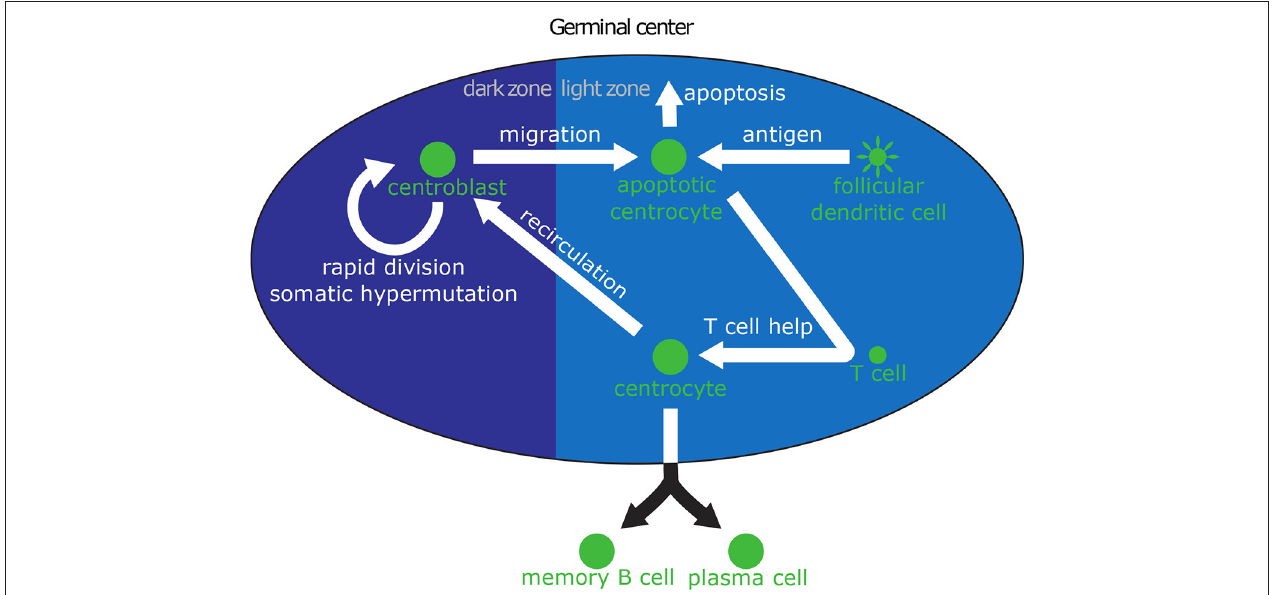
FIGURE 1 | Biological interactions in the GC relevant to B cell differentiation. Centroblasts (CBs) can be seen on the left in the dark zone, where they rapidly divide and mutate their immunoglobulin V region. After a few hours, CBs migrate to the light zone and become centrocytes (CCs). High-affinity CCs can acquire large amounts of antigen from follicular dendritic cells (FDCs), which makes them more likely to receive survival signals from helper T cells. Low affinity CCs, which acquire little or no antigen, cannot compete for T cell help and die through apoptosis. CCs that have received survival signals may either recirculate into the dark zone for another round of division and hypermutation, or leave the GC and differentiate into PCs or